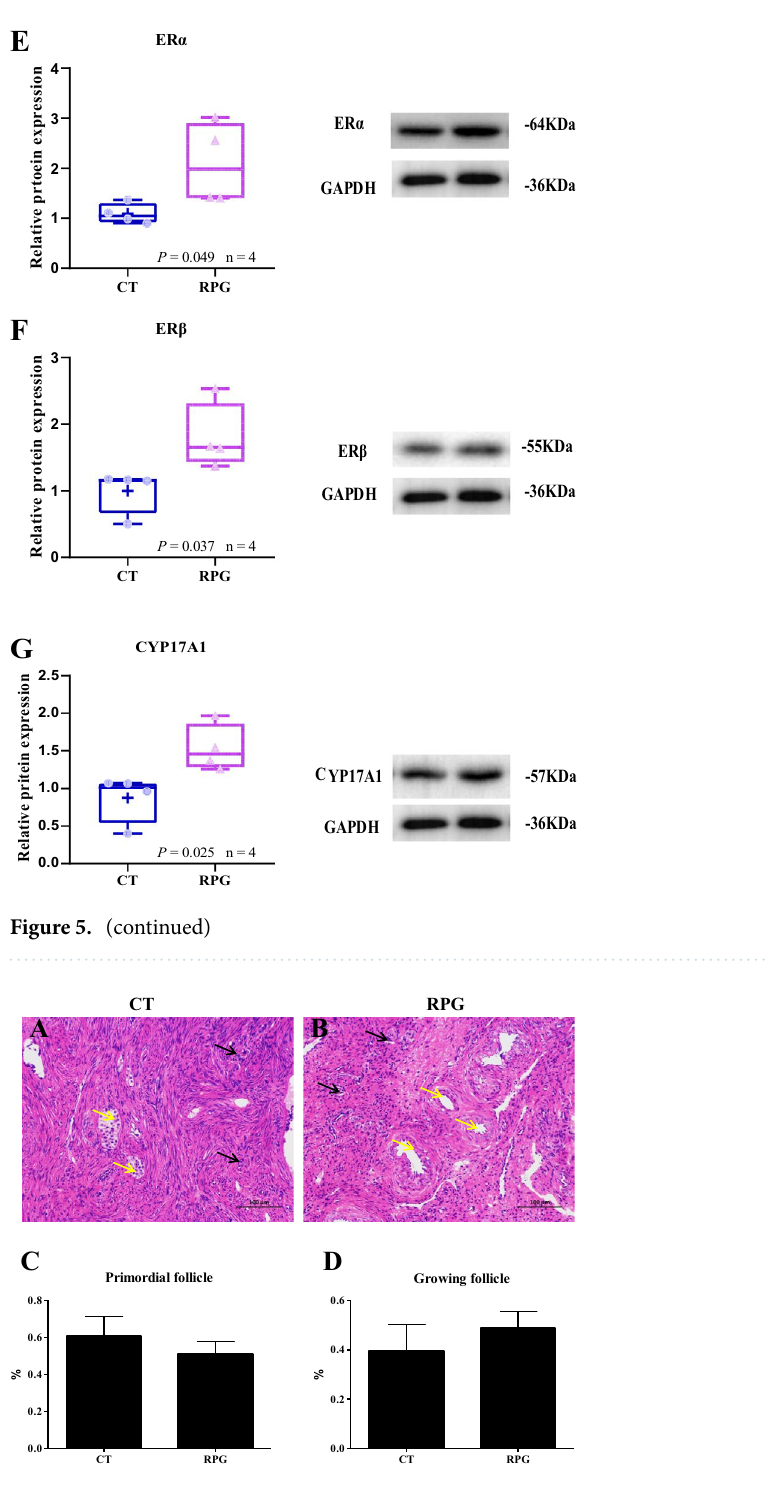
Figure 6. Effects of RPG and CT supplementation on ovarian follicle development. ( A ) Ovary of CT dairy cows. ( B ) The ovary with increasingly growing follicles after RPG treatment. ( C ) The percentage of the primordial follicle in two groups. ( D ) The percentage of growing follicles in two groups. Black arrows represent primordial follicles. Yellow arrows represent growing follicles. Scale bars = 100 μm. Data are presented as the means ±